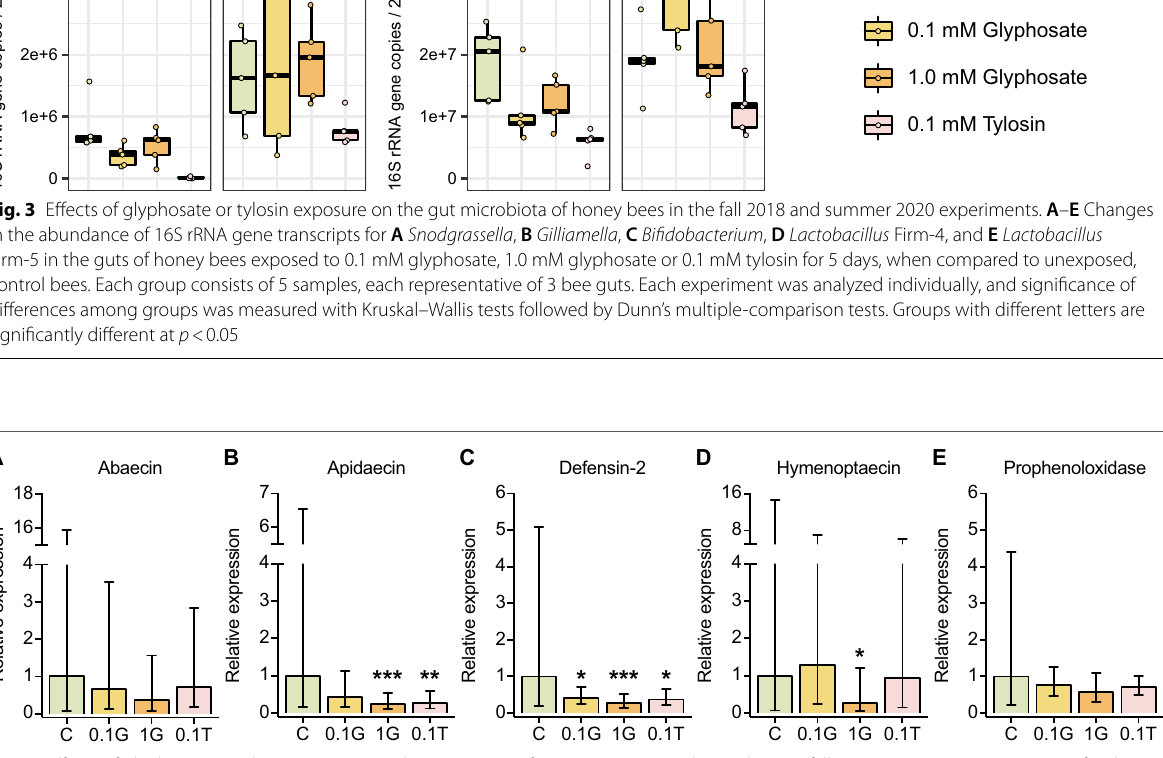
Fig. 4 Effects of glyphosate or tylosin exposure on the expression of immunity genes in honey bees in fall 2020. A – E RT-qPCR expression for the genes A abaecin, B apidaecin, C defensin-2, D hymenoptaecin and E prophenoloxidase relative to the housekeeping gene rps5 in the bodies of unexposed and 5 day exposed bees. n 17, 11, 19, and 13 for control (C), 0.1 mM glyphosate (0.1G), 1.0 mM glyphosate (1G), and 0.1 mM tylosin = (0.1T) groups, respectively. Averages and standard deviations are shown as bars and error bars. The linear regression ‘lm’ option in the pcr package in R was applied to estimate differences between control and treatment groups. * p < 0.05, ** p < 0.01, *** p <